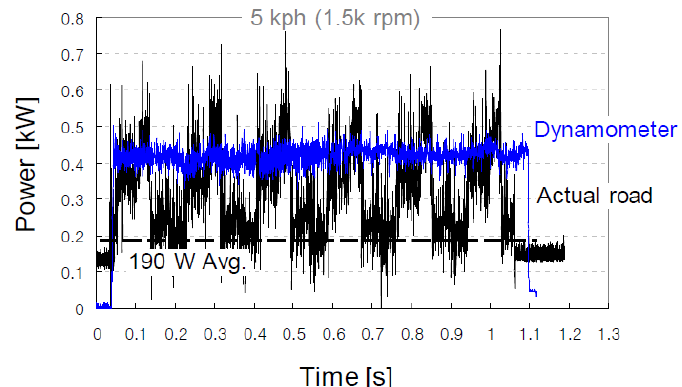
Figure 7. Results of integration tests carried out to show a discrepancy in the amount of load between our dynamometer and an actual road.